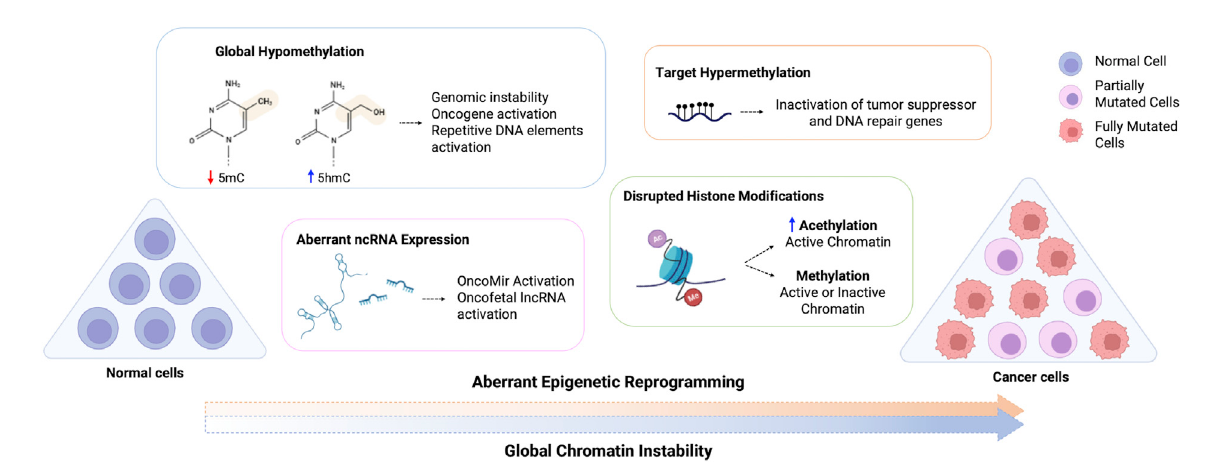
FIGURE 1 Schematic representation of the aberrant epigenetic reprogramming on cancer cells. Normal cells are aberrantly reprogramed through loss of global methylation, altered ncRNA expression, disrupted histone modi fi cations and hypermethylation of target genes, which can inactivate tumor suppressor and DNA repair genes and activate oncogenes, resulting in the global chromatin instability observed in cancer cells. 5mC, 5-methylcytosine; 5hmC,